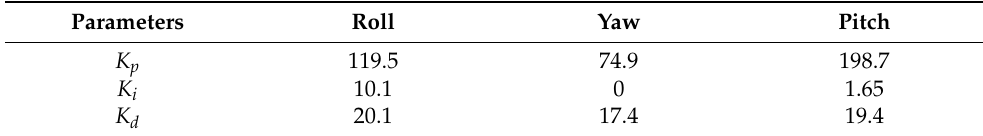
Table 3. Parameters of PID Controller.